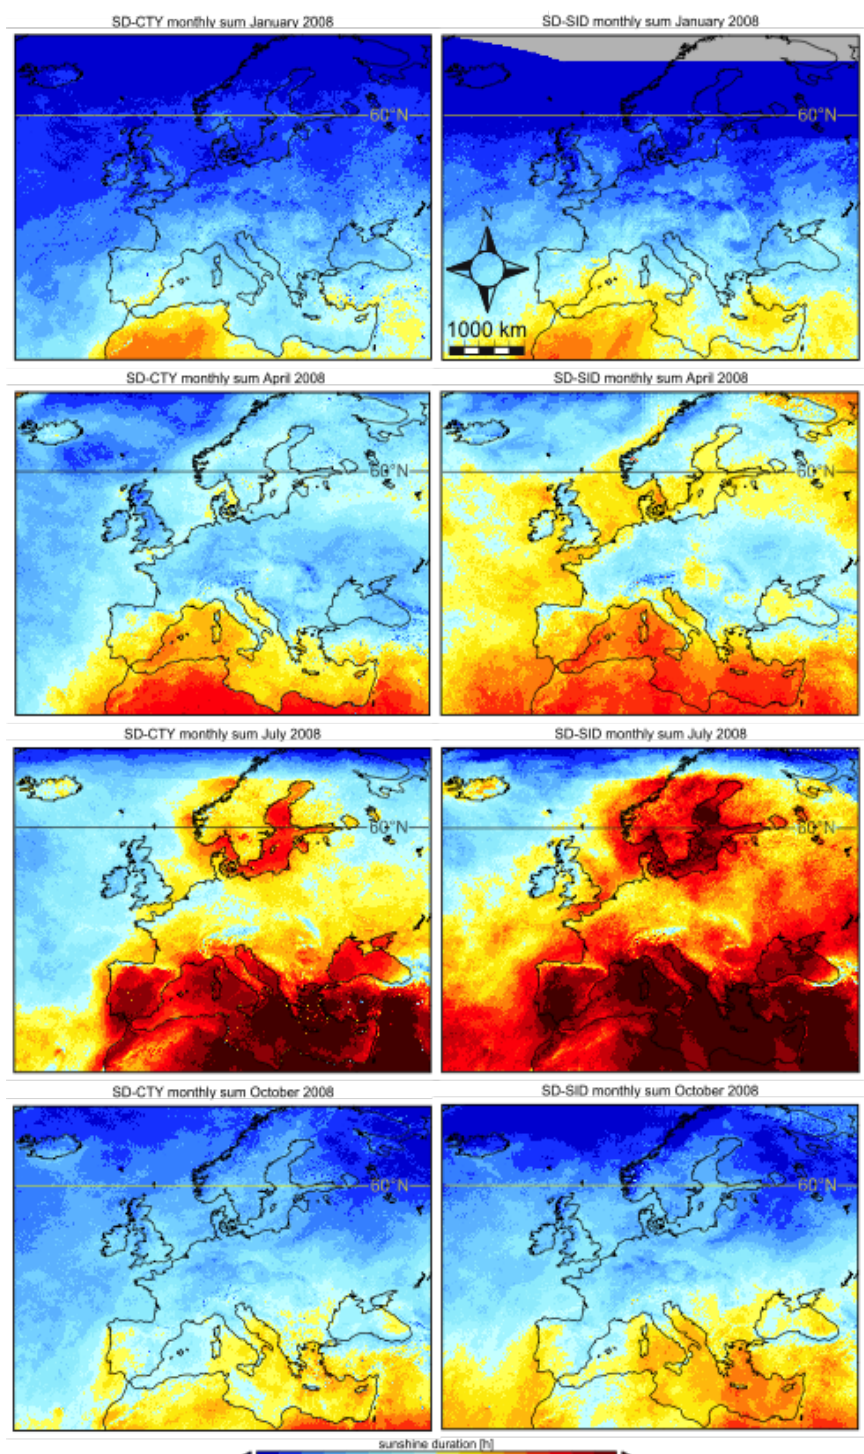
Figure 3. SD-CTY (left) and SD-SID (right) for January 2008 (top row), April (second row), July (third row) and October (bottom